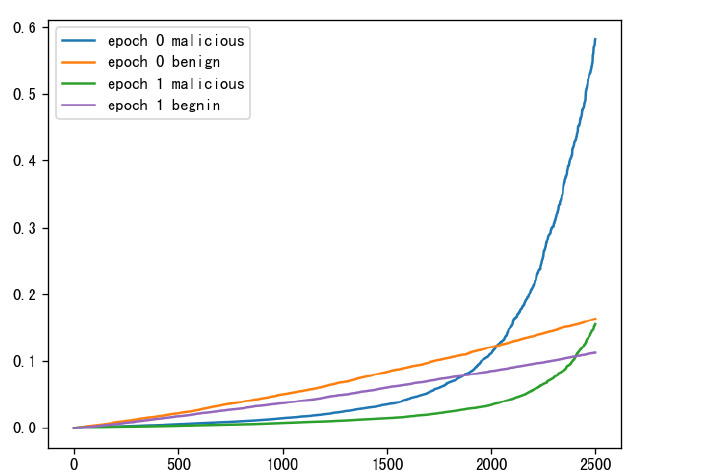
Figure 3. Training process of federated